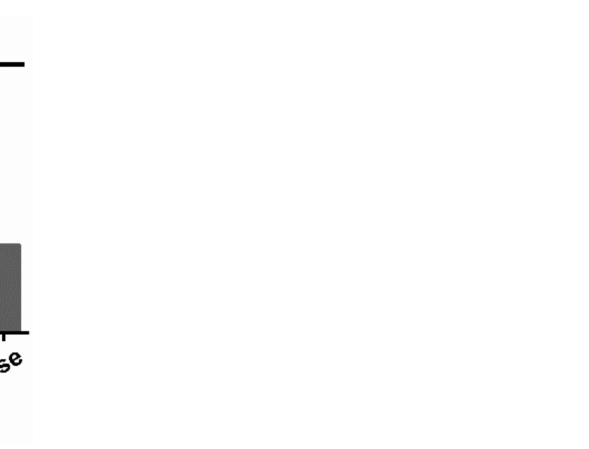
Figure 5. SIV-infected NHP and HIV-infected humans have similar decreases in plasma RA lev- els, which correlate with decreases in plasma RA levels observed in IBD relapse as compared to IBD remission . NHP (SIV+/ − ) and human (HIV+/ − ) plasma RA levels were quantified via LC-MS/MS, mean ± SEM. SIV ( − ), n = 10; SIV (+) 50 weeks, n = 5; HIV ( − ), n = 6; HIV (+) for ≥ 52 weeks, n = 6. IBD remission and IBD relapse levels were median plasma RA levels observed in n = 38 and n = 24 patients, respectively from a study by Paul et al. 2018 [85] (* p < 0.05). Adapted from Byrareddy SN et al., 2016 [61].